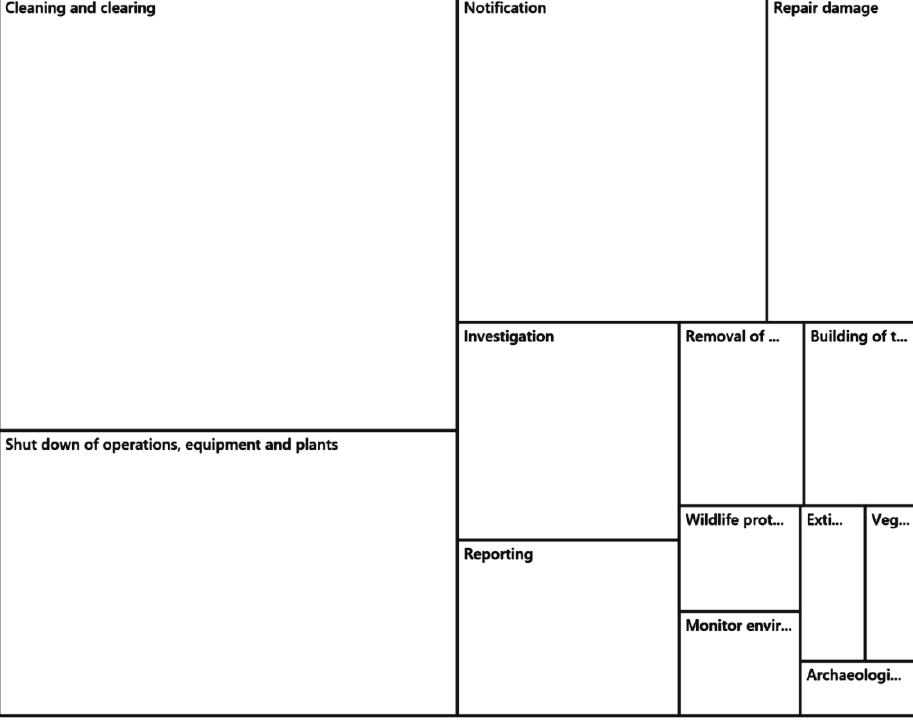
Figure 7. Tree map analysis of immediate actions– compared by number of coding references (nodes)